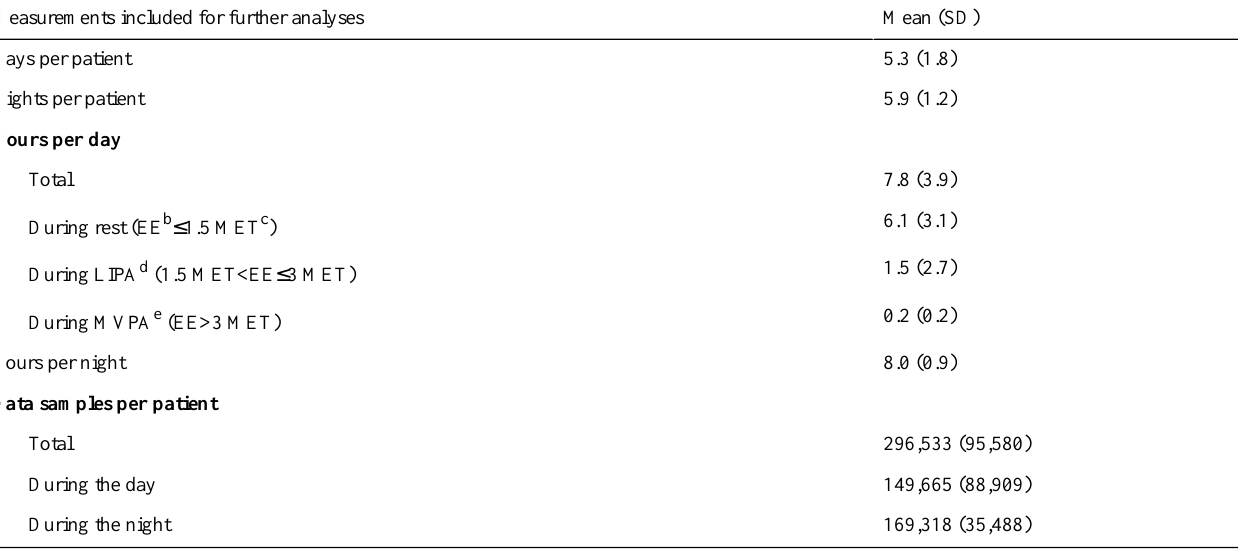
Table 2. Summary of the amount of peripheral blood oxygen saturation (SpO 2 ) measurements that were included for further analyses a .